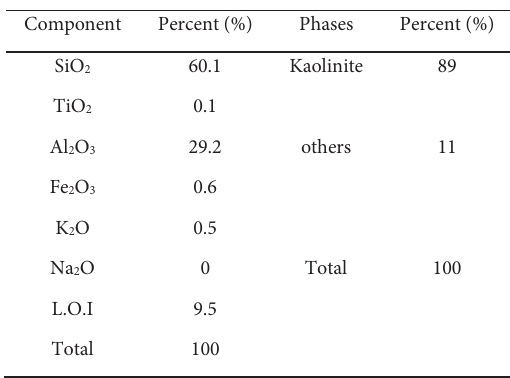
Table 1. Analysis of kaolin clay